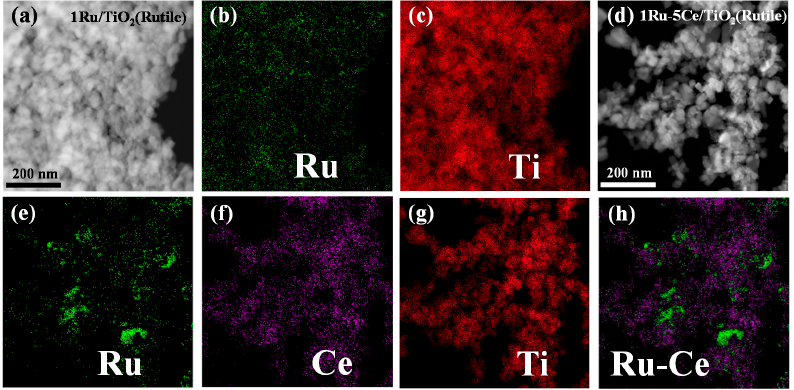
Figure 9. Representative HAADF ‐ STEM images ( a , d ) and STEM ‐ EDS mapping images of ( b , e ) Ru, ( e , g ) Ti, and ( f ) Ce, and ( h ) Ru ‐ Ce for 1Ru/TiO 2 (Rutile) ( a – c ) and 1Ru ‐ 5Ce/TiO 2 (Rutile) ( d – h ).